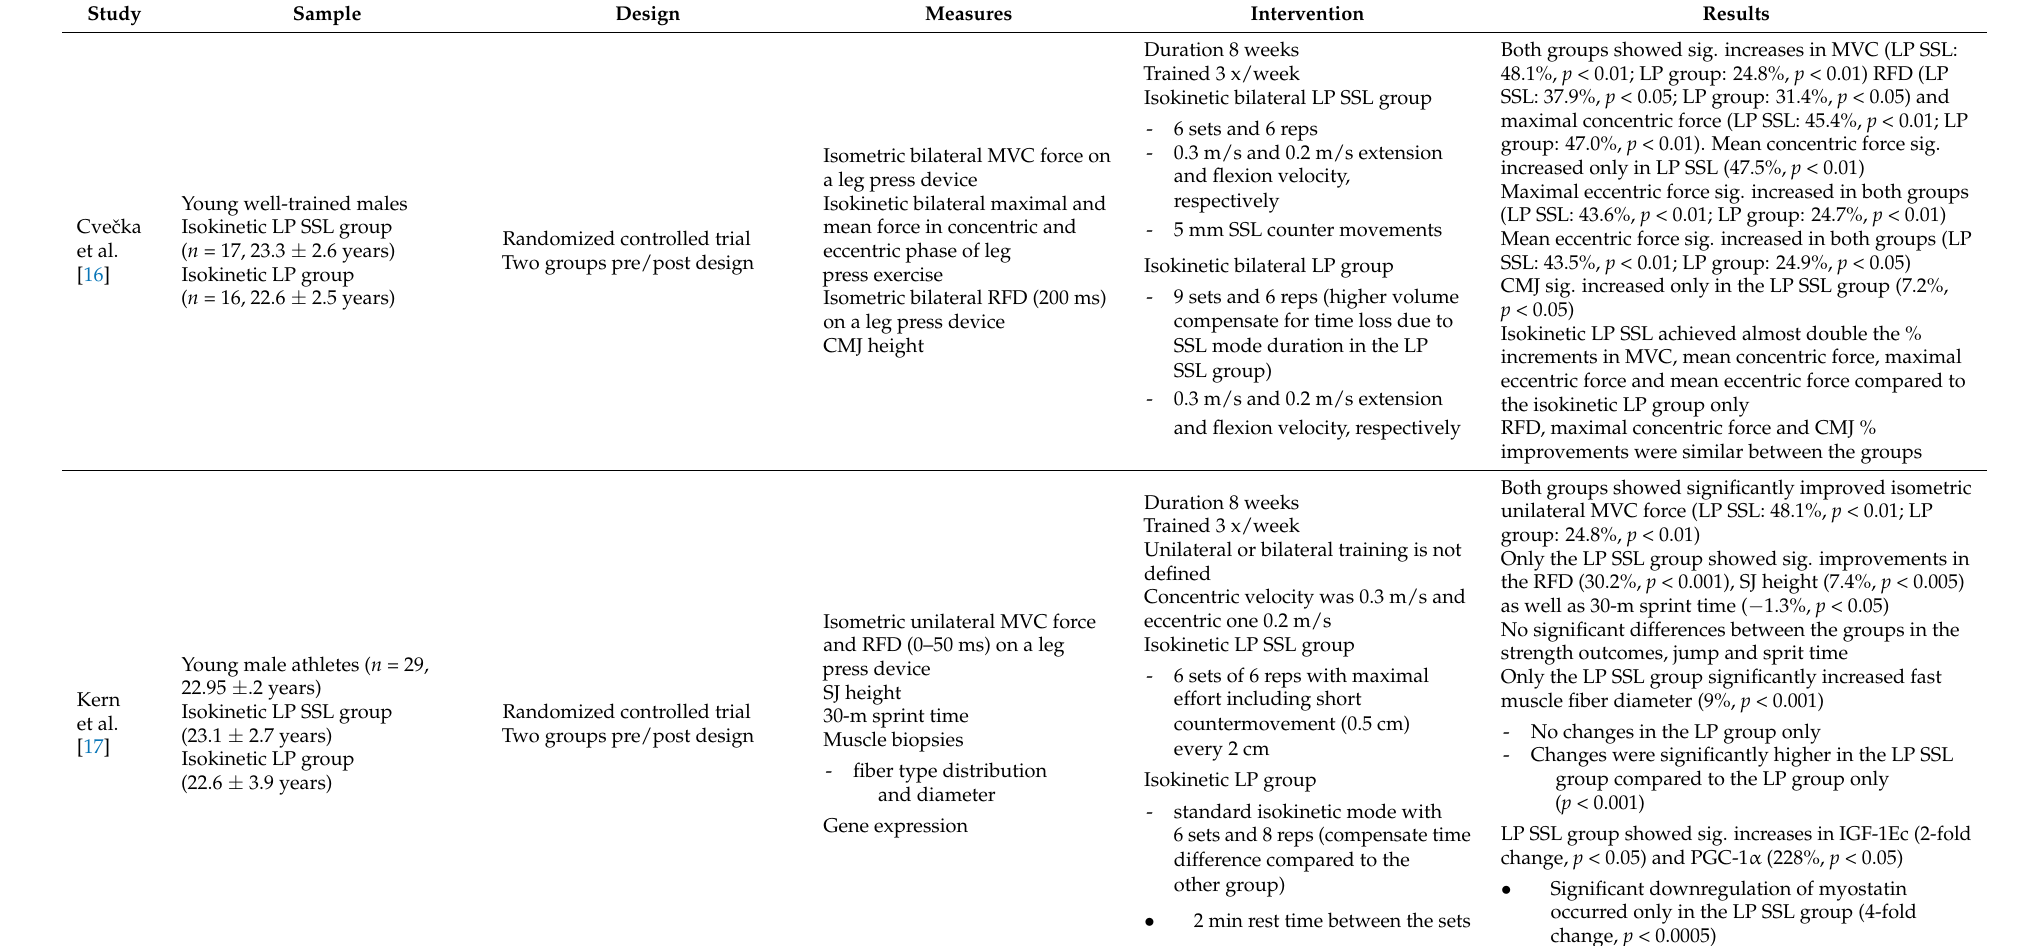
Table 3. Long-term training studies using a leg press dynamometer during strength